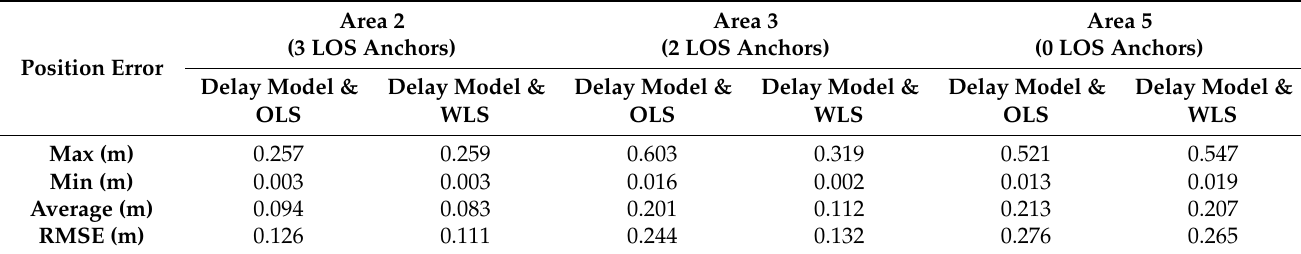
Figure 11. Experiment 1 results for the delay model with WLS.